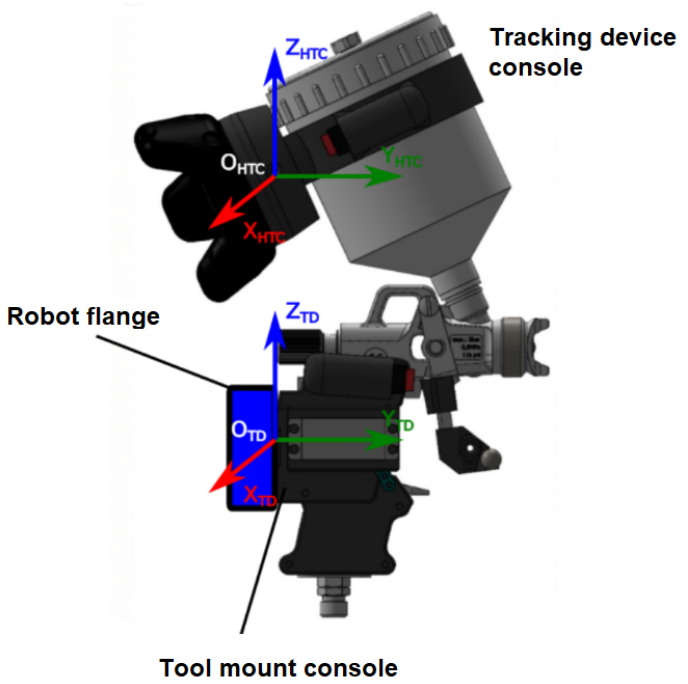
Figure 5. Tracking device calibration—referring tracker pose with respect to robot